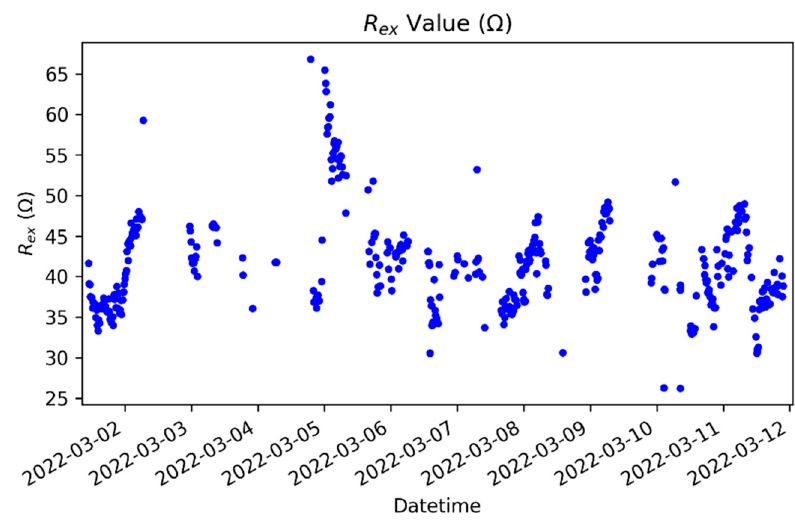
Figure 12. Extracellular resistance ( R ex ) values obtained along ten days, for a healthy subject.